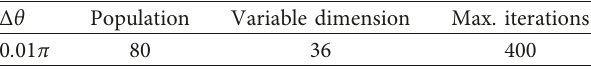
Table 4: Parameter values of the